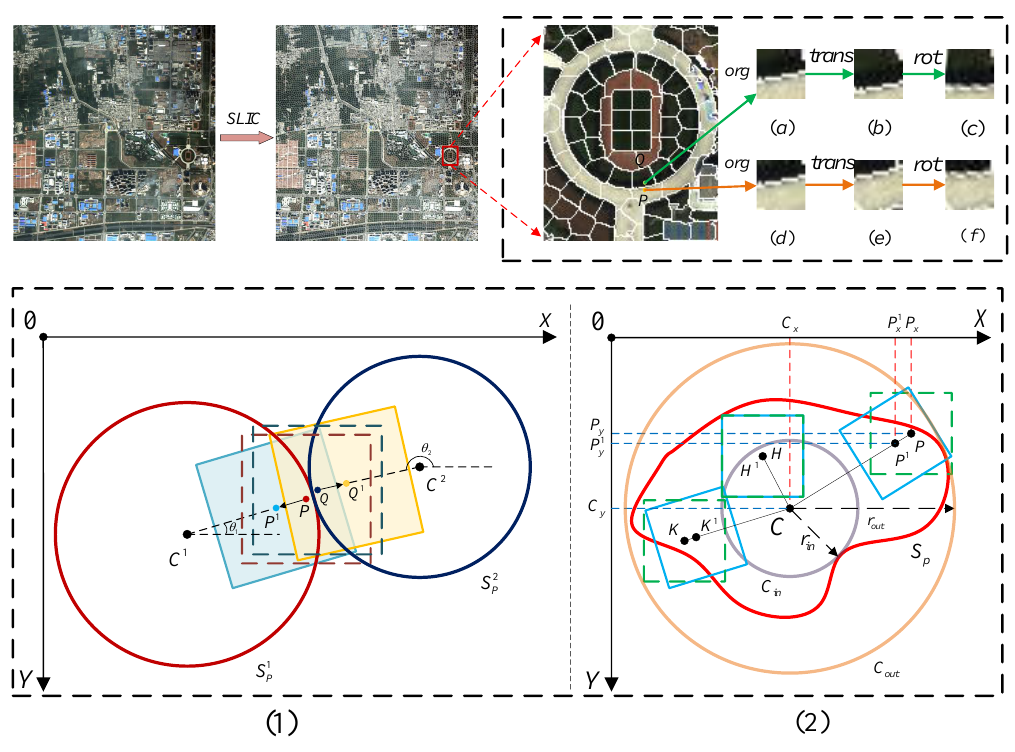
Figure 2. The overall process of determining the neighbourhood pixels and centre position of the patches. (1) The mathematical analysis of the concrete sampling process is shown below the figure. The lower left sub-figure (1) represent sampling process of two pixels located in different superpixel regions; the lower right sub-figure (2) represents sample sampling process of pixels at different locations in the same superpixel region. (2) The actual sampling results are shown in the upper right: (a) and (d) are the original sampling results; (b) and (e) are the sample patches after neighborhood